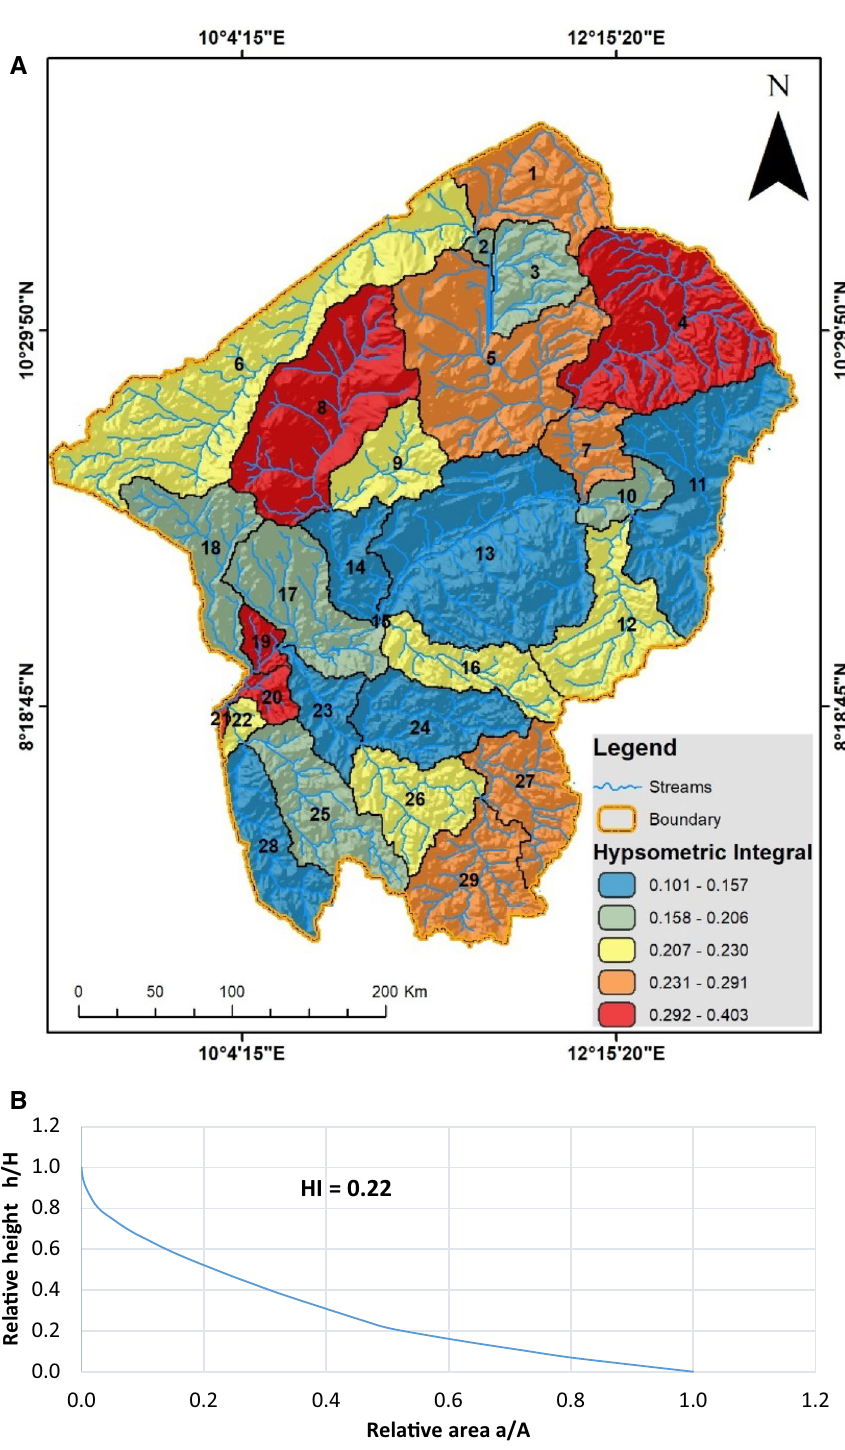
Fig.9 a Hypsometric integral of upper Benue River watershed b Hypsometric